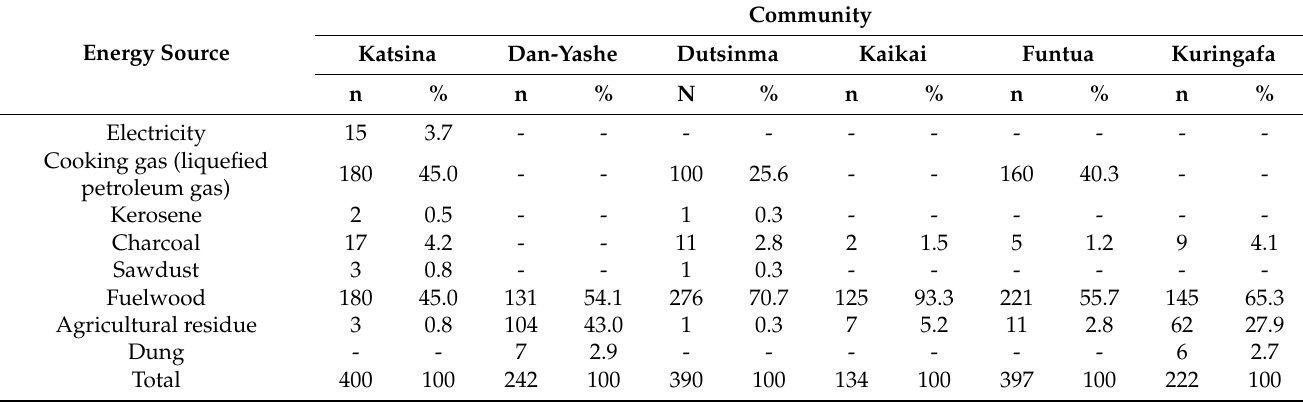
Table 9. Various household energy sources across the sampling